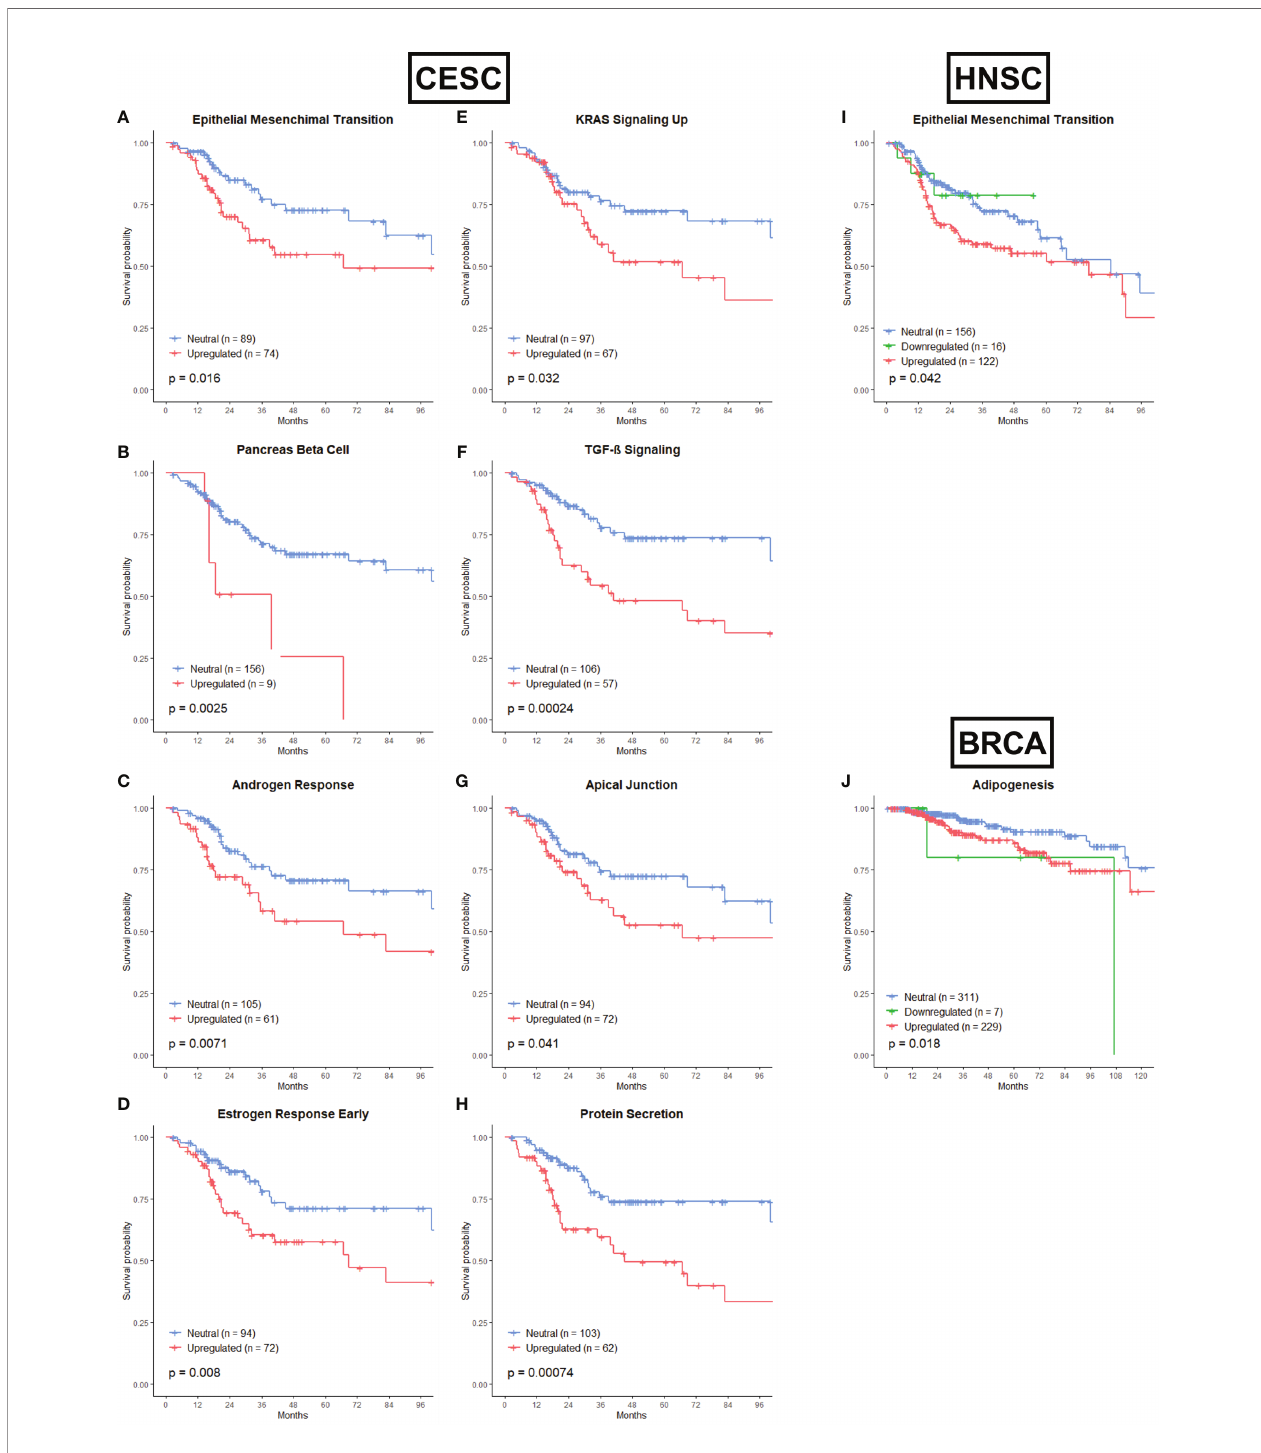
FIGURE 5 | Associations of gene sets of the Development, Signaling, Cellular Component and Pathway categories with patient overall survival times. Kaplan-Meier plots of CESC patients associated with OS for (A) the Epithelial Mesenchymal Transition gene set, (B) the Pancreas Beta Cell gene set, (C) the Androgen Response gene set, (D) the Estrogen Response Early gene set, (E) KRAS Signaling Up gene set, (F) TGF- b Signaling gene set, (G) Apical Junction gene set and (H) Protein Secretion gene set. (I) Kaplan-Meier plot for the Epithelial Mensenchymal Transition gene set of HNSC patients associated with OS. (J) Kaplan-Meier plot for the Adipogenesis gene set of BRCA patients associated with